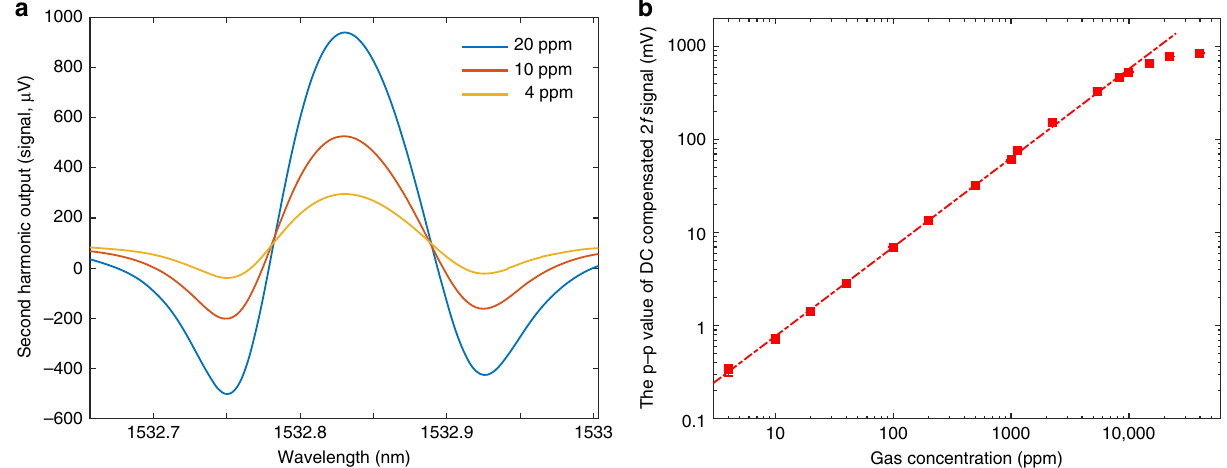
Fig. 6 Results of dynamic range test. a 2 f -signal when pump laser is tuned across the P(13) line of acetylene for 4, 10, 20 ppm acetylene concentration. b The p – p value of the 2 f signal as functions of gas concentration. Error bars show the s.d. from fi ve measurements and the magnitudes of the error bars are scaled up by 50-fold for clarity reason. The mean probe power at PD is ~9.5 dBm. The time constant of the lock-in ampli fi er is 1 s for gas concentration below or equal 20 ppm and is 100 ms for above 20 ppm.